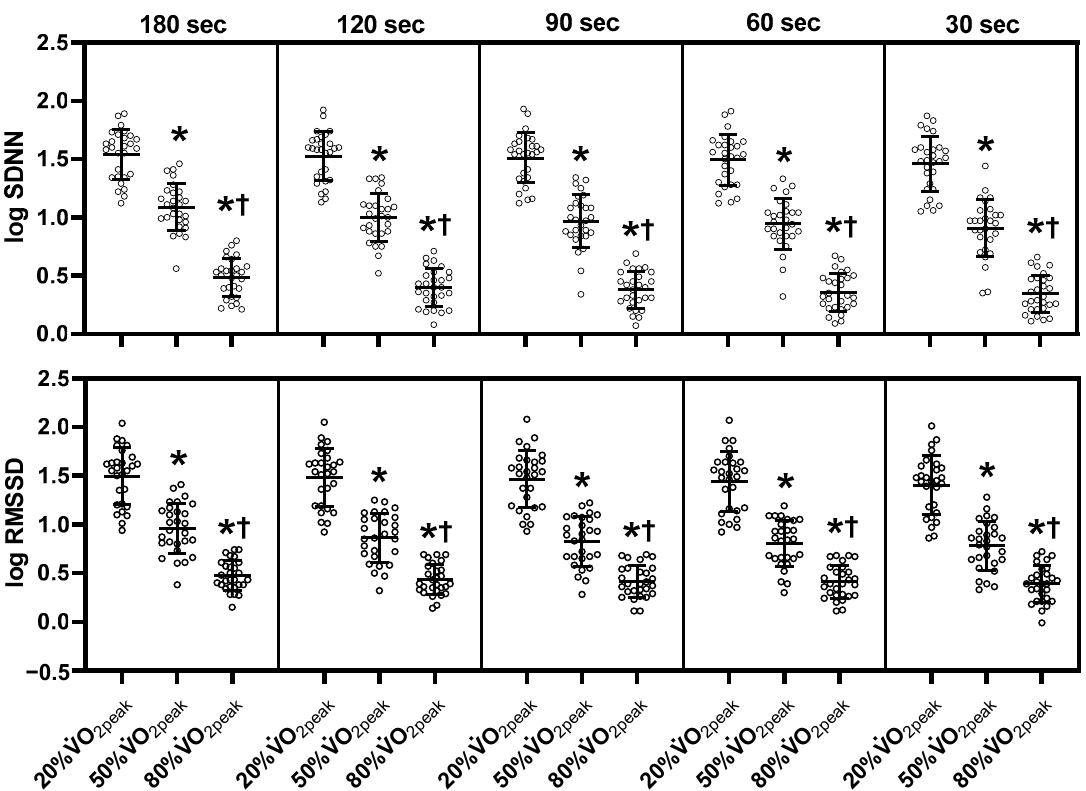
Figure 2. Changes of each ultra-short-term segment of time-domain HRV parameters during exercise. SDNN, standard deviation of all RR intervals; RMSSD, root mean square of successive RR interval differences; log, logarithmic; sec, seconds; VO 2peak , peak oxygen uptake. The middle line indicates the mean value. The top and bottom lines indicate the SD. The white plots indicate the individual data of participants. Note that there is missing data (see the Materials and Methods section). *, p < 0.05 vs. 20% V